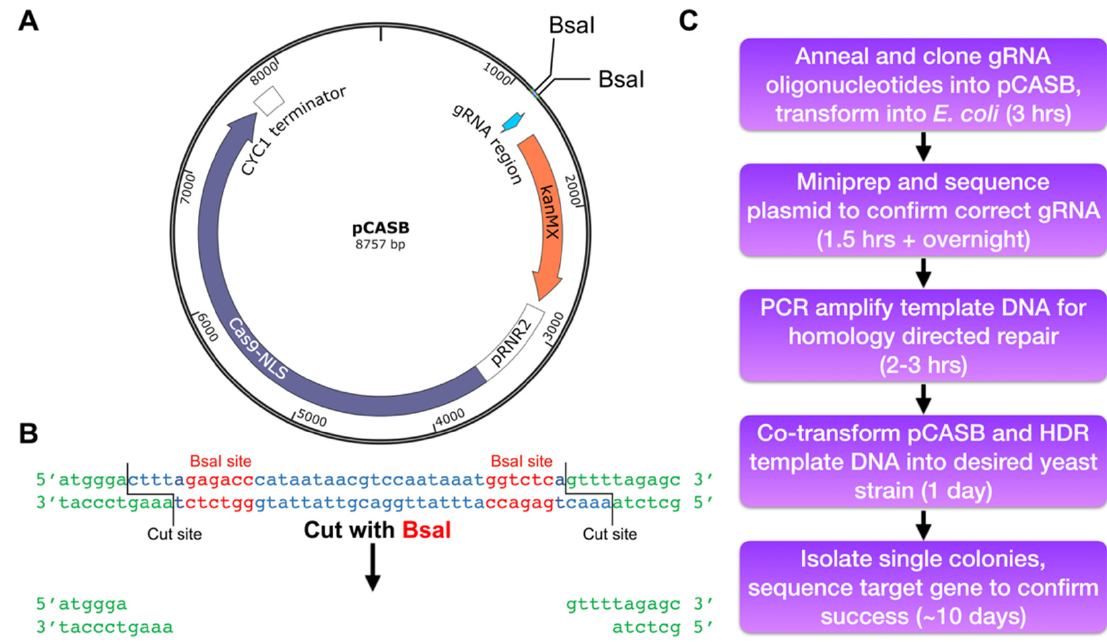
Figure 1. ( A ) Schematic of the pCASB plasmid, highlighting the locations of the BsaI cut sites. ( B ) The modified gRNA locus of pCASB. BsaI recognition sites are labeled in red, DNA lost after cutting is labeled blue, and unaltered plasmid backbone left behind after cutting in green. ( C ) Schematic of the CRISPR-Cas9 gene editing protocol, starting with gRNA cloning and ending with a modified yeast strain.